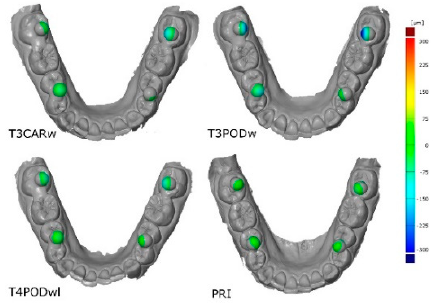
Figure 5. Graphical illustration for the typical three-dimensional arch distortion for the investigated intraoral scanners (IOS). Table 2. Results for deviations in x-, y-, and z-direction for the di ff erent spheres and the investigated IOS.